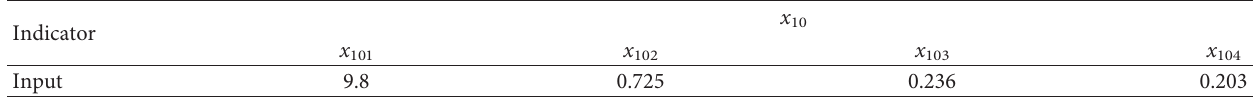
Table 10: Assessment inputs of economic vulnerability indicators.